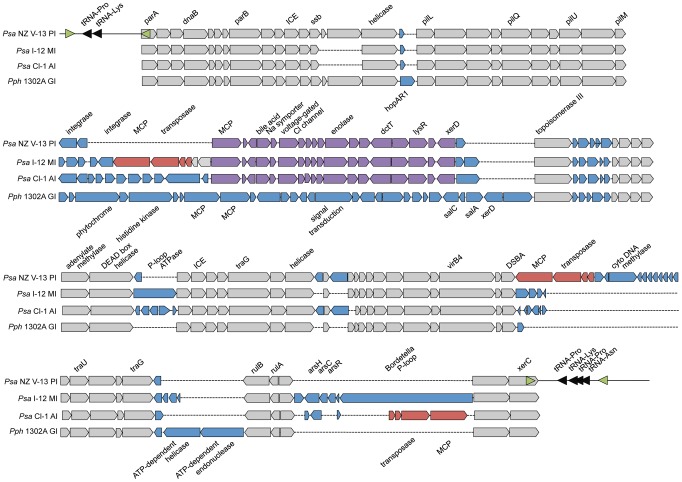
Structure of the Pacific, Mediterranean, Andean and PPHGI-1 islands.Grey genes are orthologs with ∼75% nucleotide identity. Blue genes are variable accessory genes. Purple genes are accessory genes with complete conservation across the Pacific, Andean and Mediterranean islands. Red genes have translocated via transposon-mediated insertion events. Each island is bounded by 52 bp att sequences overlapping tRNA-Lys. Primer sites for the confirmation of excision and chromosomal integration are shown in green (Figure S4).